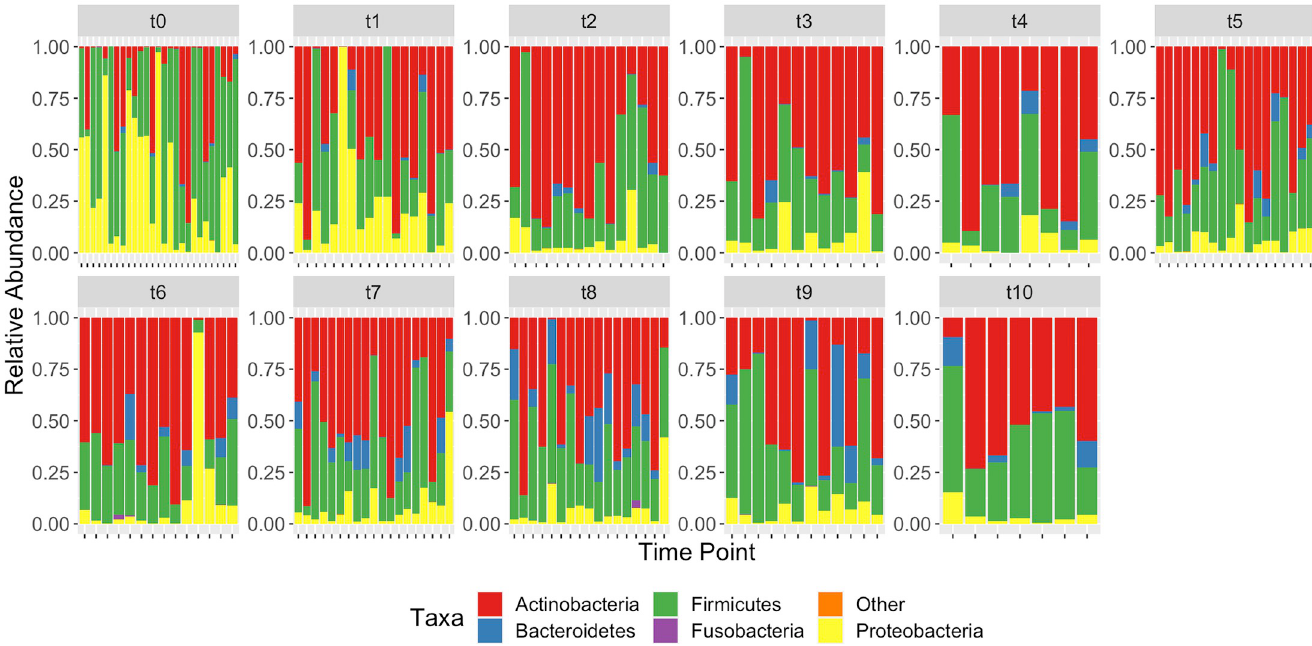
Fig 1. Taxonomic profile showing the infants’ gut microbial composition at phylum level grouped by time points. Samples at birth (or within one week of life) are represented by t0 and months 1–10 are represented by t1, t2, t3, t4, t5, t6, t7, t8, t9, and t10 respectively. The major phyla shown are Actinobacteria (red), Proteobacteria (yellow), Firmicutes (green), Bacteroidetes (blue), Fusobacteria (purple) and others (orange).